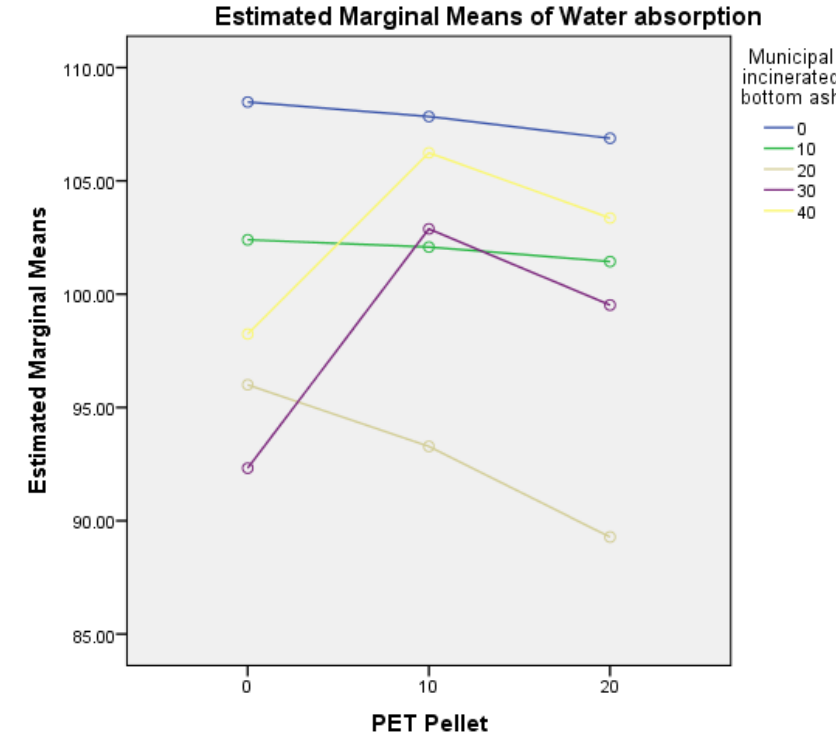
Figure 9. Estimated marginal means of water absorption between PET pellets and MIBA.